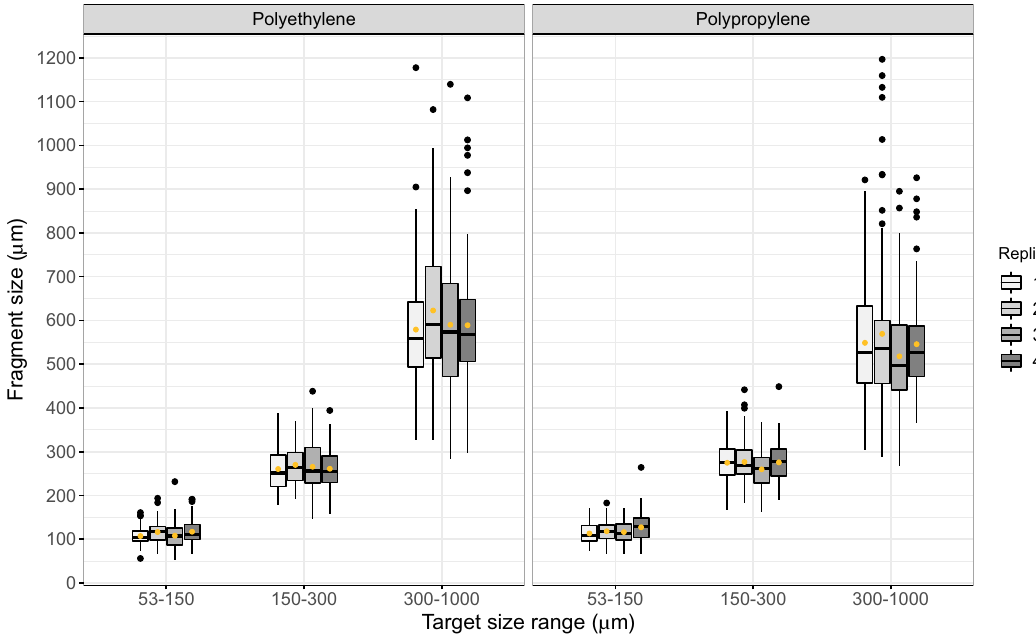
Figure 2. Polyethylene and polypropylene microfragments matched their targeted size ranges: 53–150, 150–300, and 300–1000 μm. Box-and-whisker plots illustrate the full spread of data for each polymer type, size class and production replicate including median, inter-quartile and min–max values. Mean microfragment size (yellow dots) fell within the target range for each sample. Size classes were all significantly distinct from one another (ANOVA, Tukey post-hoc test, P <